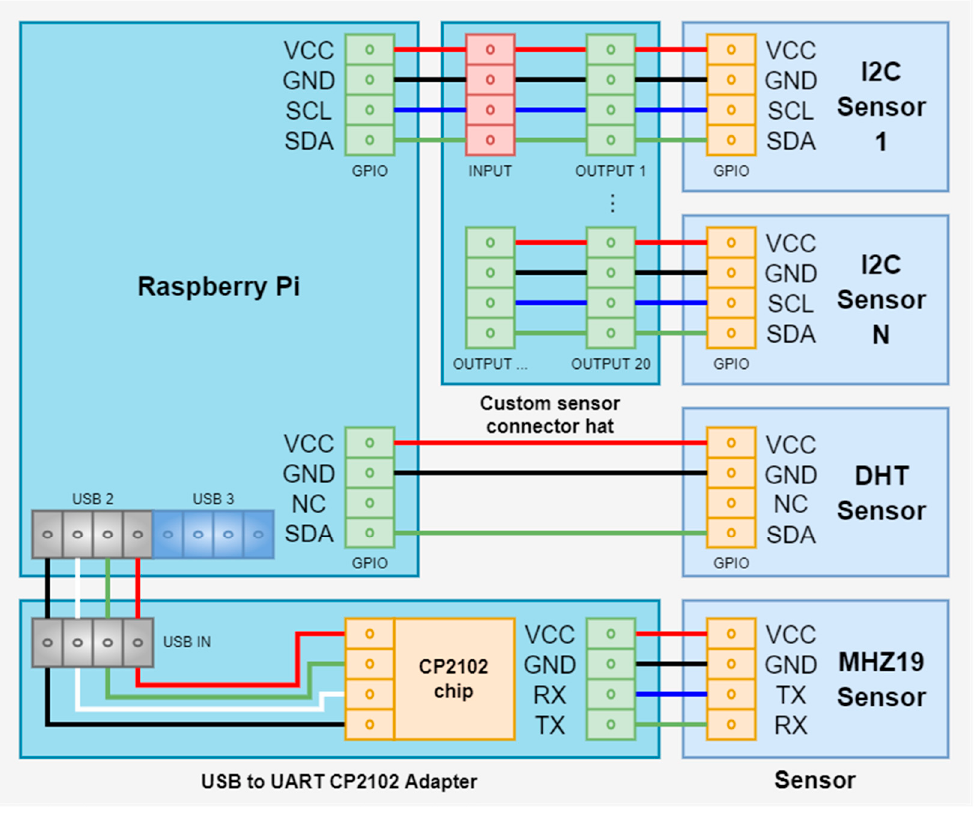
Figure 1. Example of sensors connection with a Raspberry Pi